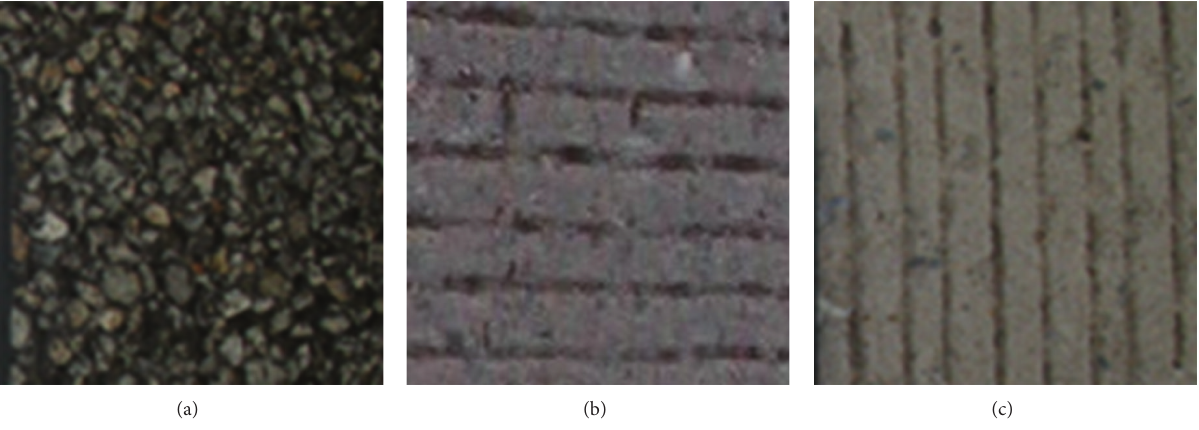
Figure 1: Pavement surface types: (a) SMA, (b) 30 mm trans., and (c) 18mm